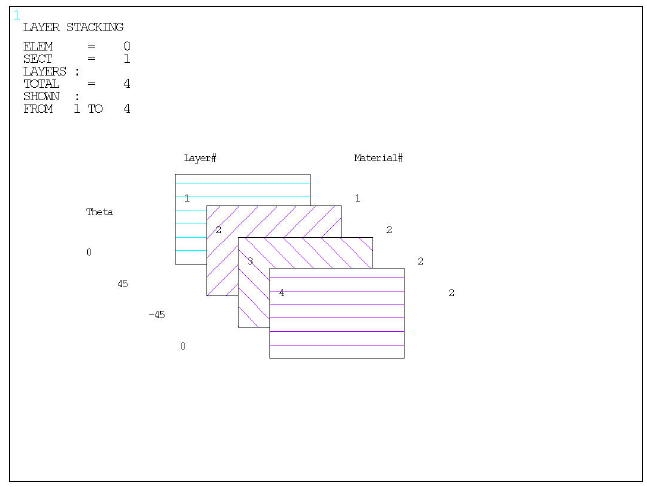
Figure 1. Diagram of fiber ply sequence and angle. Referring to the actual situation, full constraints are applied to the bottom of the finite element model, and 30 MPa uniform internal pressure is applied on the inner wall. The stress and displacement contours output by APDL are shown in Figures 4 and